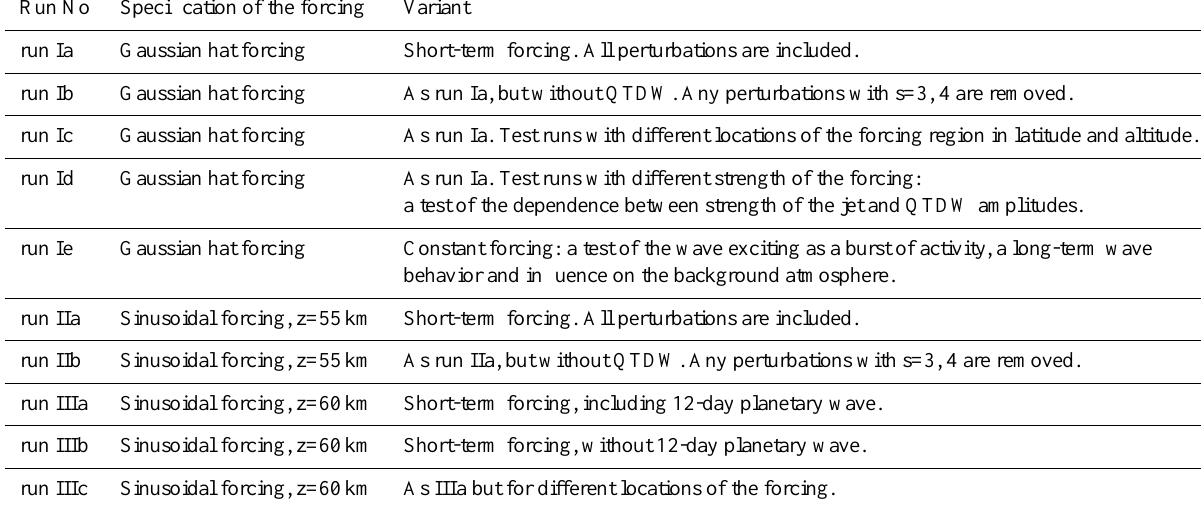
Table 1. Summary of numerical runs. Run No Specification of the forcing Variant run Ia Gaussian hat forcing Short-term forcing. All perturbations are included. run Ib Gaussian hat forcing As run Ia, but without QTDW. Any perturbations with s=3, 4 are removed. Gaussian hat forcing As run Ia. Test runs with different locations of the forcing region in latitude and altitude. Gaussian hat forcing As run Ia. Test runs with different strength of the forcing: a test of the dependence between strength of the jet and QTDW amplitudes. Gaussian hat forcing Constant forcing: a test of the wave exciting as a burst of activity, a long-term wave behavior and influence on the background atmosphere. Short-term forcing. All perturbations are